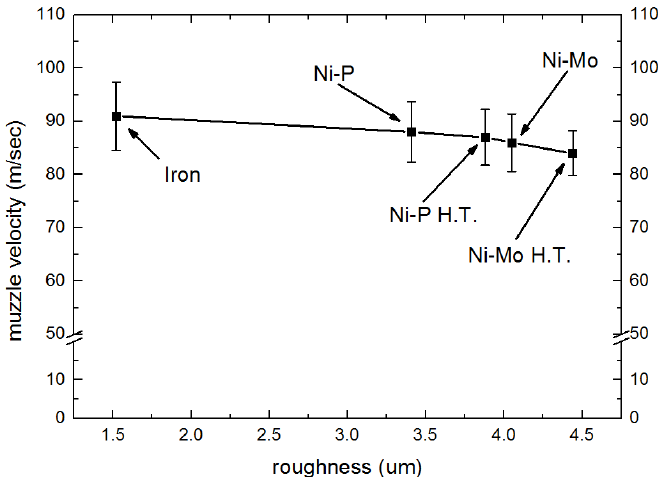
Figure 4. Surface roughness against armature velocity.